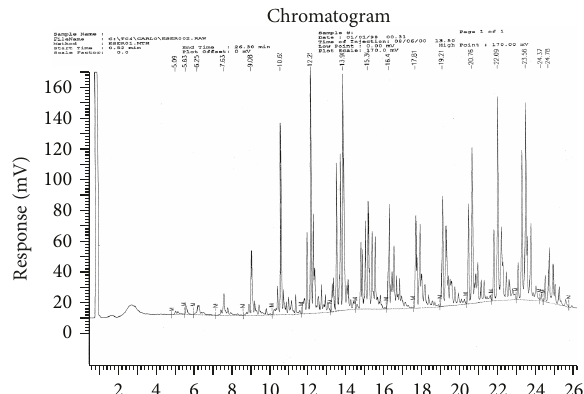
Figure 4: GC profile of authentic butter supplemented with 10% (w/w)